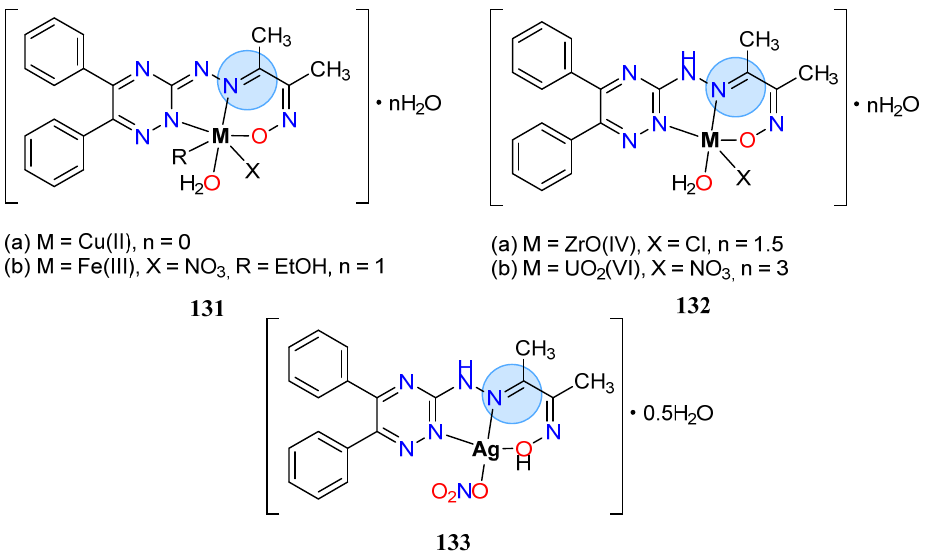
Figure 65. Mononuclear complexes derived from ( E ) ‐ 3 ‐ (2 ‐ (5,6 ‐ diphenyl ‐ 1,2,4 ‐ triazin ‐ 3 ‐ yl)hydra ‐ zono)butan ‐ 2 ‐ one oxime studied for their antimicrobial